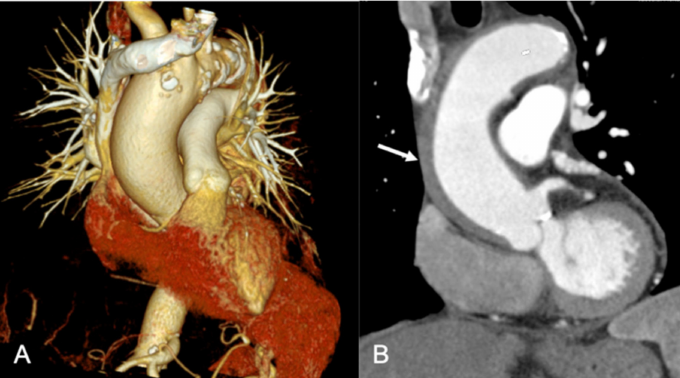
Figure 3. A 47-year-old woman with chest pain. ( A , B ) Combined CT evaluation of the aorta, pul- monary, and coronary arteries revealed type A dissection (arrow), no signs of pulmonary embolism or coronary stenosis.